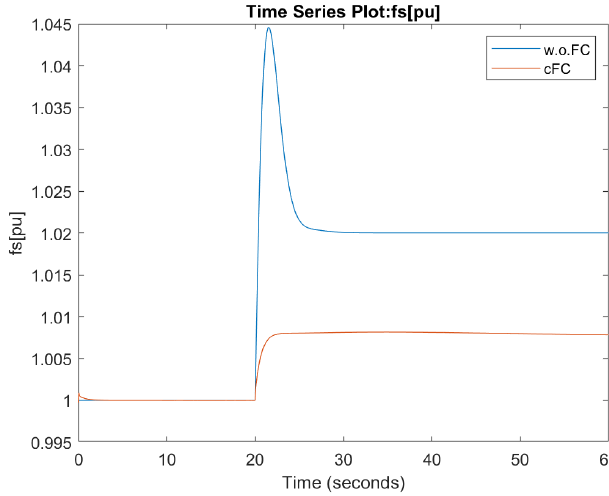
Figure 24. Simulation 17 frequency trend.